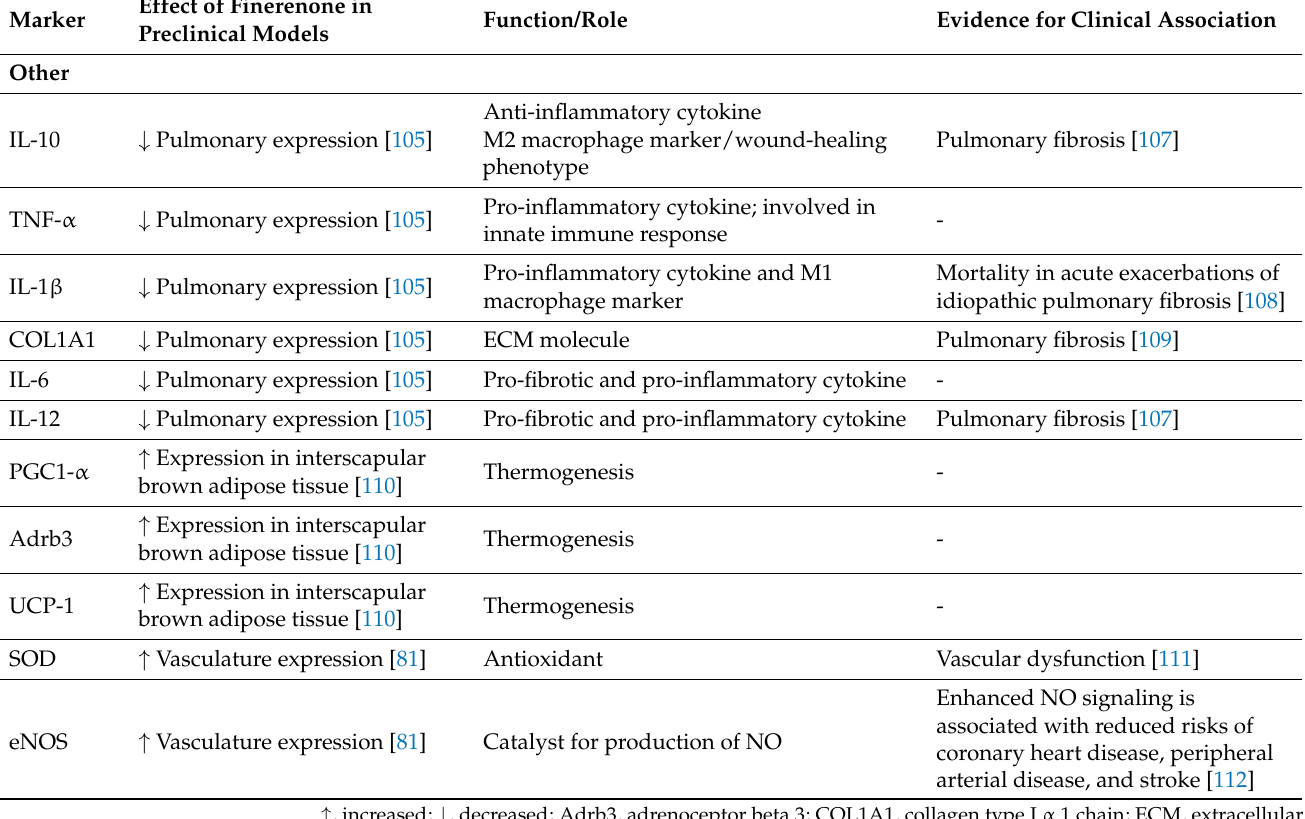
Table 3. Biomarkers determined in other organs that are modulated by finerenone in preclinical studies and their clinical